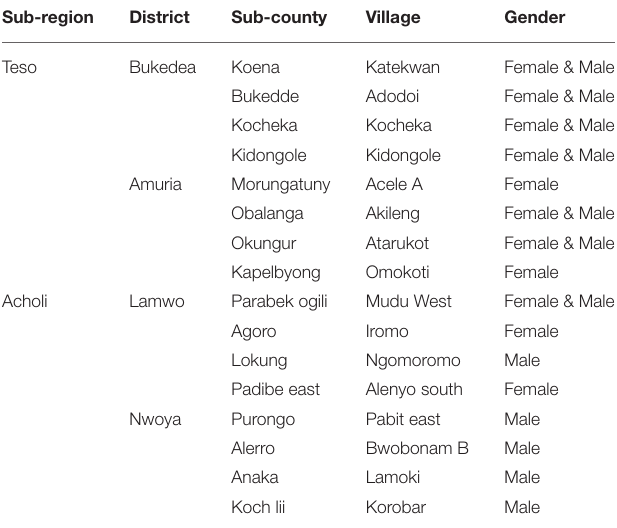
TABLE 1 | FGD distribution across the two sub-regions.